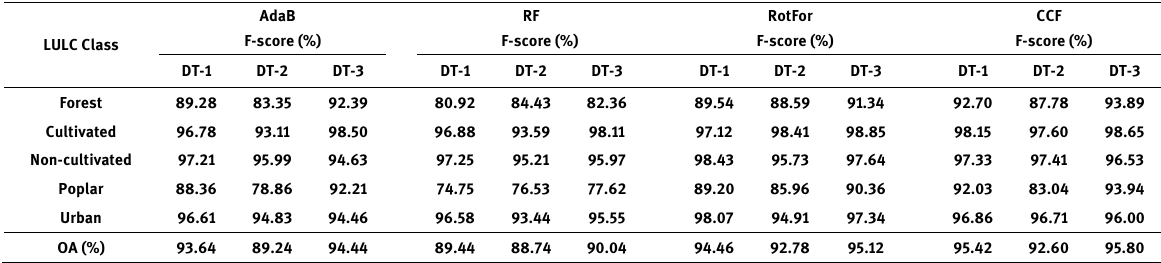
Table 2: Classification Accuracy of Datasets.